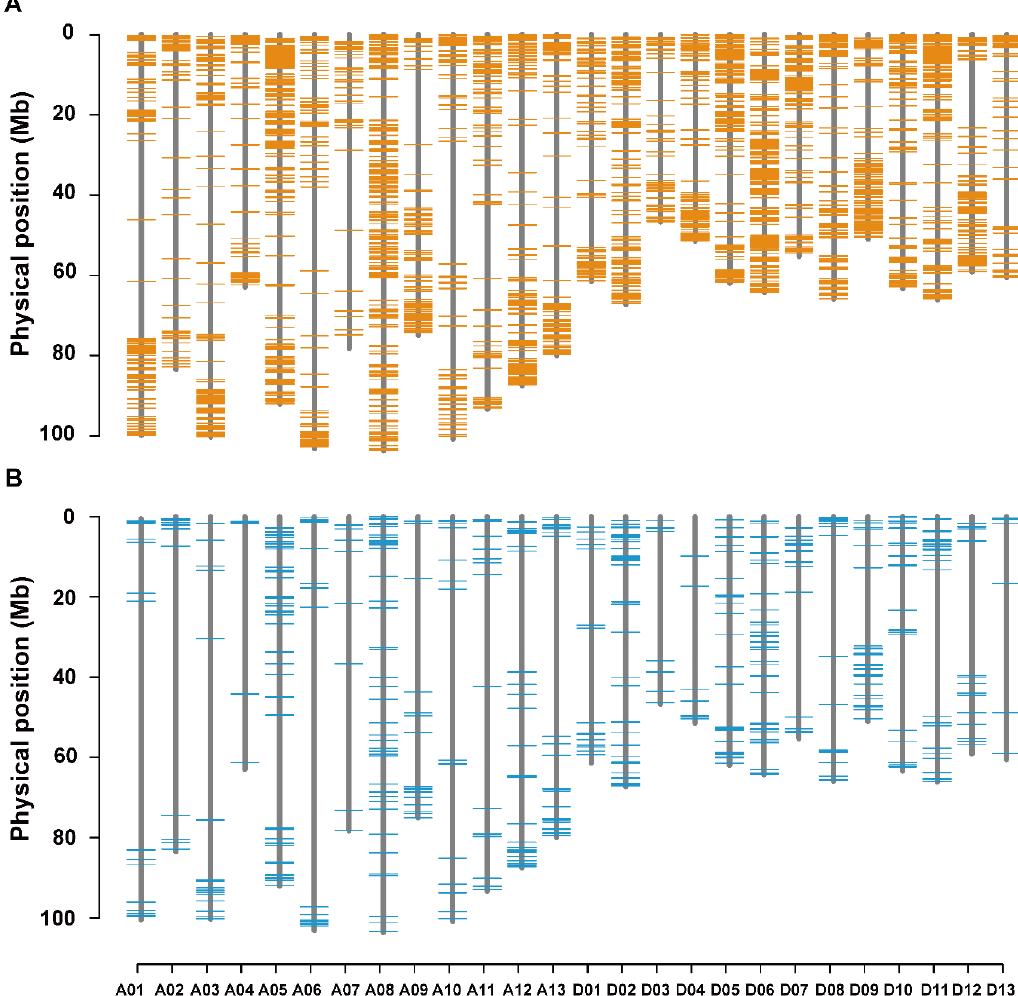
Figure 4. The distribution of DNA polymorphisms detected between 9053 and sGK9708. The color of orange and blue represented SNPs ( A ) and InDels ( B ), respectively.